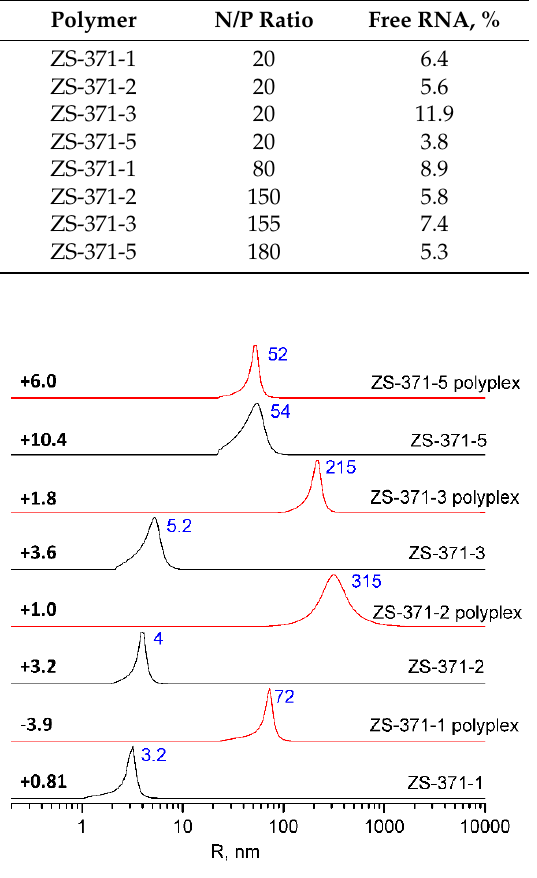
Figure 4. Dynamic light scattering (DLS) data (volume % vs. R h ) for the polymers and polyplexes. Numbers at the left side– ζ -potential values. Initial polymer concentration was 4 mg/mL, siRNA–10 µ M with a polymer to siRNA ratio of 4:1 which corresponds to the conditions of the in vitro